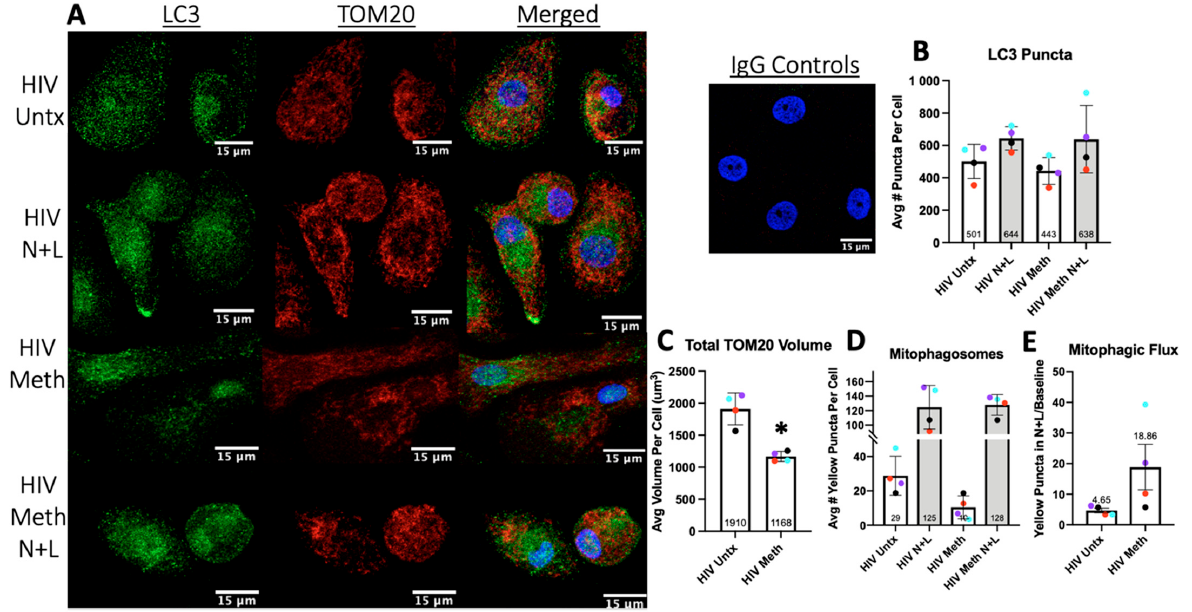
Figure 6. Confocal immunofluorescence studies of autophagosomes (LC3) and mitochondria (TOM20) in HIV-infected macrophages untreated (HIV Untx) or treated with meth for 24h and N + L added in the last 4 h of treatment for indicated conditions. ( A ) Representative images of LC3 puncta (green), mitochondria (TOM20, red), and nuclei (DAPI, blue) and corresponding rabbit and mouse IgG controls. ( B ) Number of LC3 puncta per cell in a Z-series was quantified in Volocity according to the Materials and Methods section. ( C ) Total amount of TOM20 staining was quantified per cell. ( D ) Number of LC3 puncta positive for TOM20, mitophagosomes (yellow puncta), per cell were quantified in a Z-series. ( E ) Number of mitophagosomes in ( D ) was used to quantify mi- tophagic flux with and without meth treatment. n = 4 with 50–75 cells analyzed per condition per experiment; * p < 0.05, paired t test. Scale bar is 15µm. Error bars represent SEM.